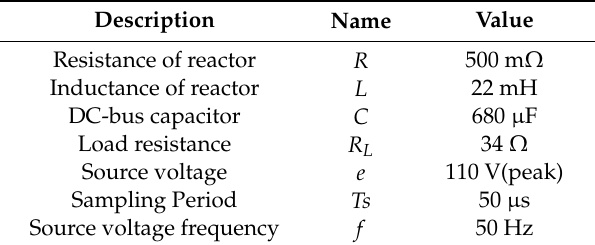
Figure 7. Laboratory experimental prototype. Table 3. Electrical Parameter of Prototype.